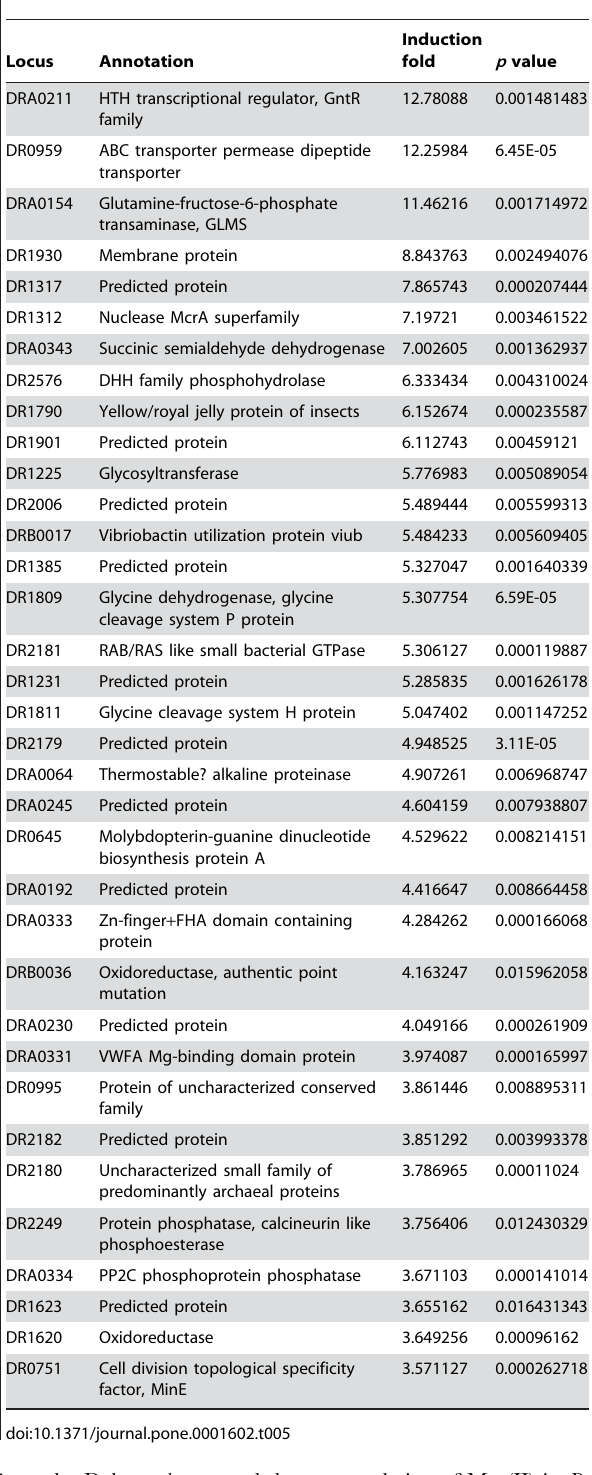
Table 4. The 36 most highly repressed genes in MOxyR. Table 5. The 36 most highly induced genes in